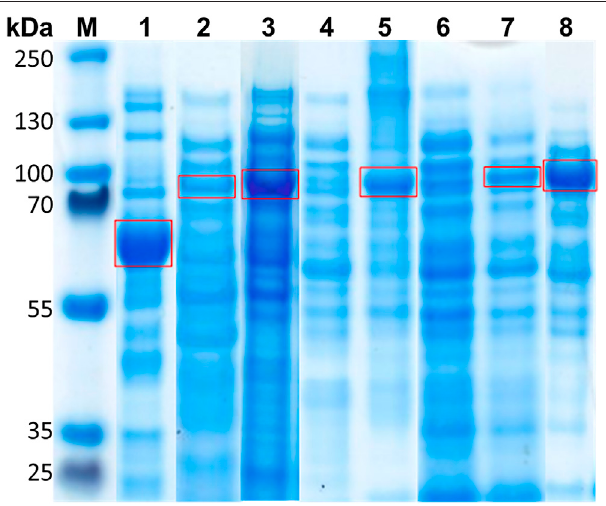
( Figure 9 .). The enzymatic reactions were performed on 0.5 ml